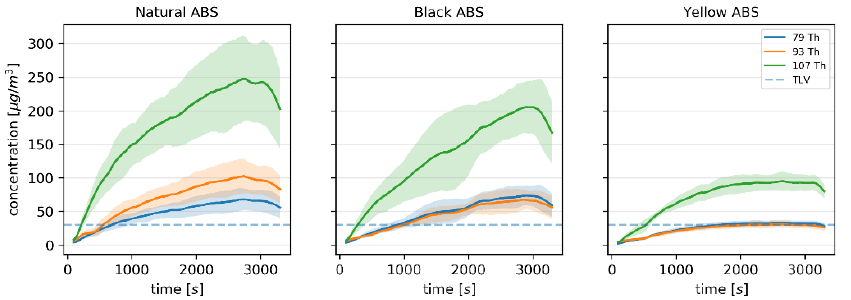
Figure 3. The concentration of ions characteristic for benzene, toluene, ethylbenzene, and xylenes (BTEX) compounds in the 3D printer enclosure during printing with 3 different ABS filaments determined using PTR-MS. The solid line indicates the average ± standard deviation (shaded area), and the dashed line indicates the threshold limit value (TLV) for the 79 Th ion at 30 μg m 3 .